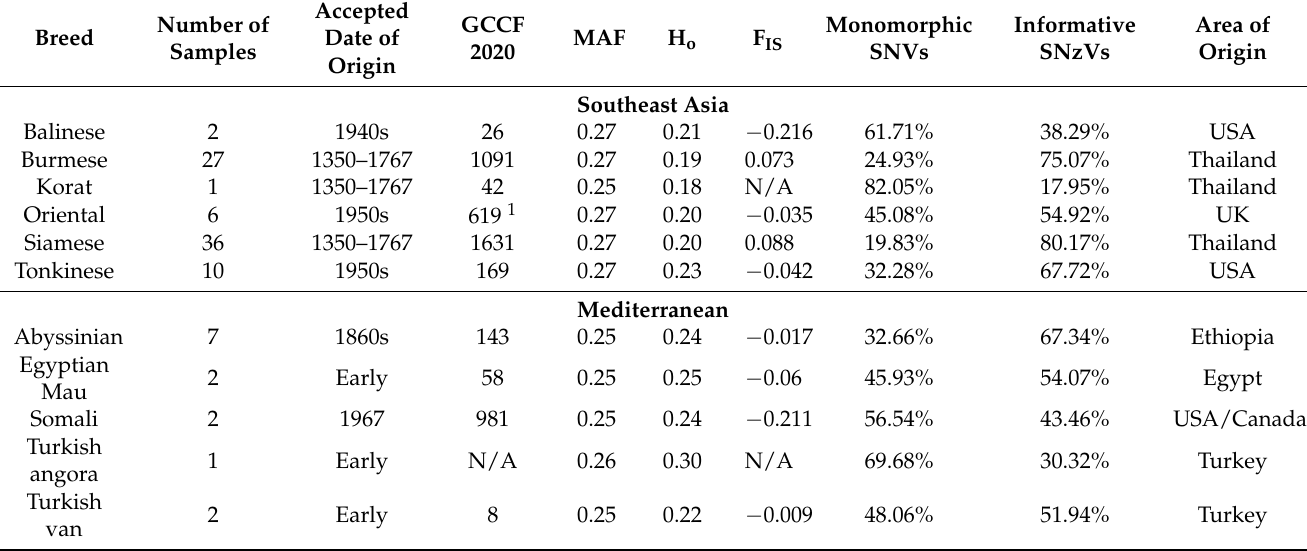
Table 2. Cat breeds and their sample numbers in the cleaned